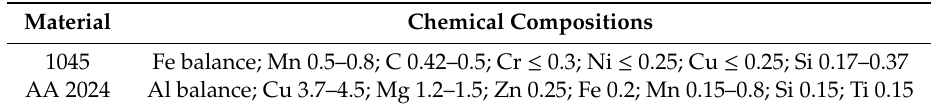
Table 1. Chemical compositions of steel 1045 and aluminum alloy 2024.